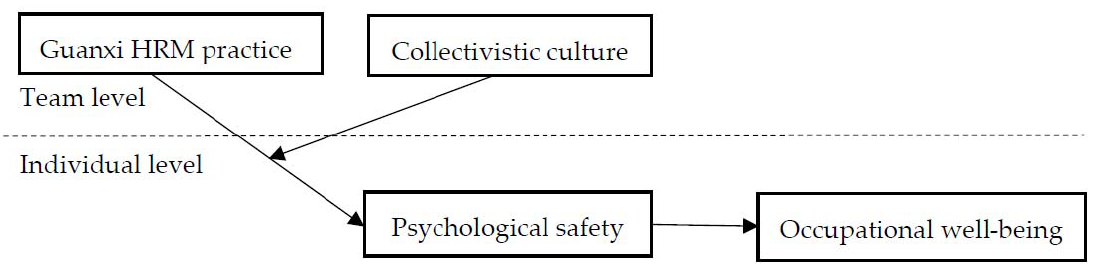
Figure 1. Theoretical Model.